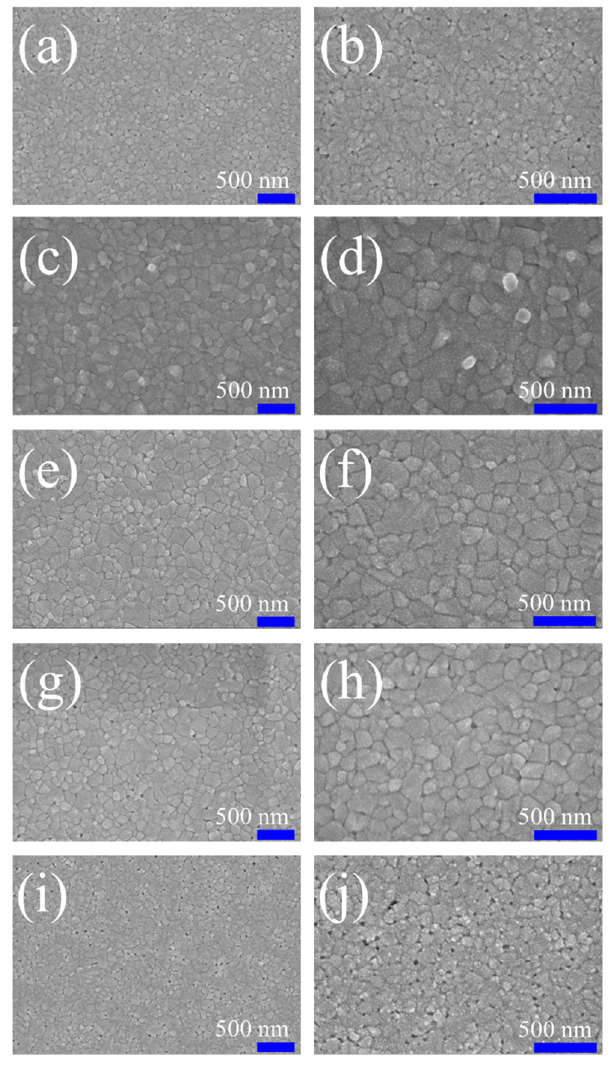
Figure 3. SEM images of the MAPbI 3 layers over the FTO/NiO X /POSS with various POSS con- tents: ( a , b ) control; ( c , d ) POSS-0.005; ( e , f ) POSS-0.01; ( g , h ) POSS-0.015; and ( i , j ) POSS-0.05. The magnification in the left images and the right images are x30k and x50k,